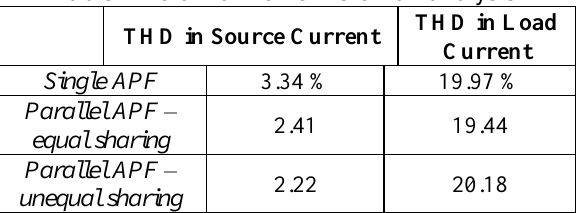
Table2. Total harmonic Distortion analysis